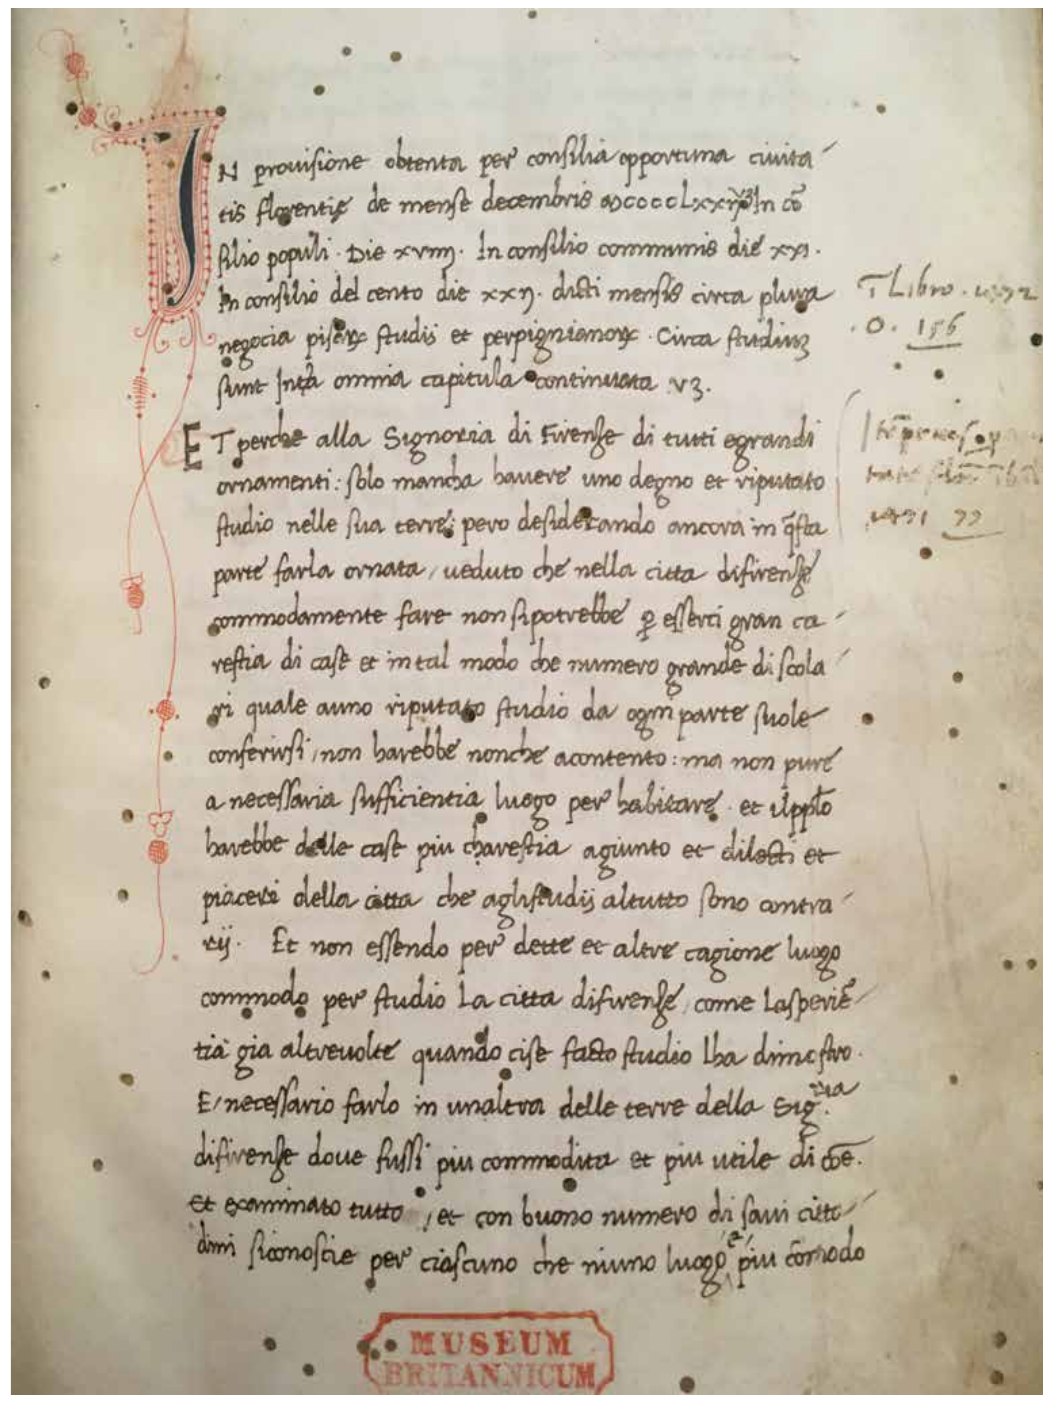
Fig. 1. BL, Add. MS. 8537, f.